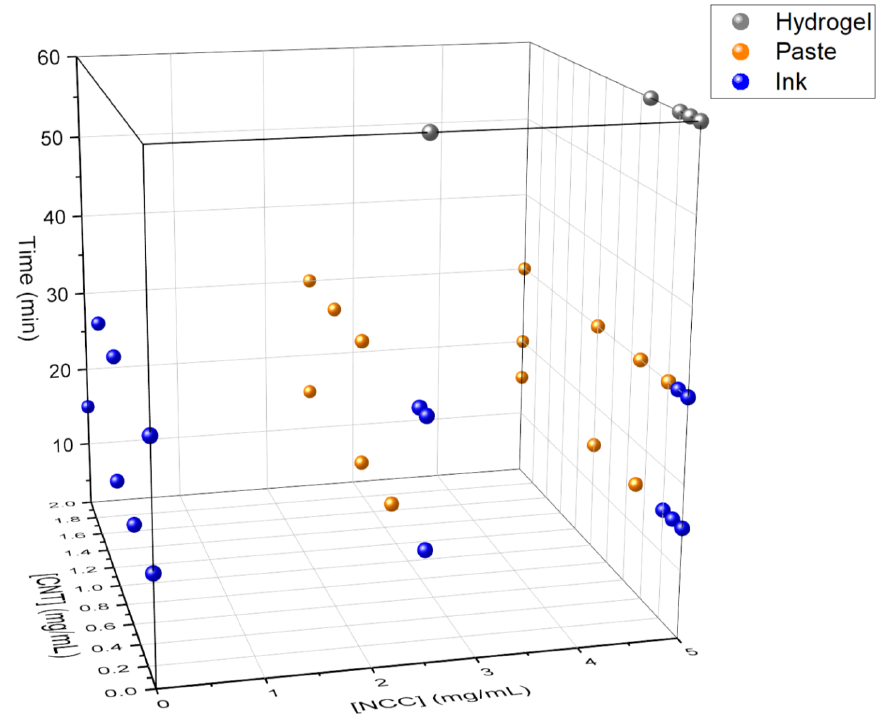
Figure 2. Three-dimensional scatter plot representing the conditions to obtain inks (blue), viscous pastes (orange) and self-standing hydrogels (gray). The effect of adding aqueous ammonia is herein represented, at different amounts of CNTs.